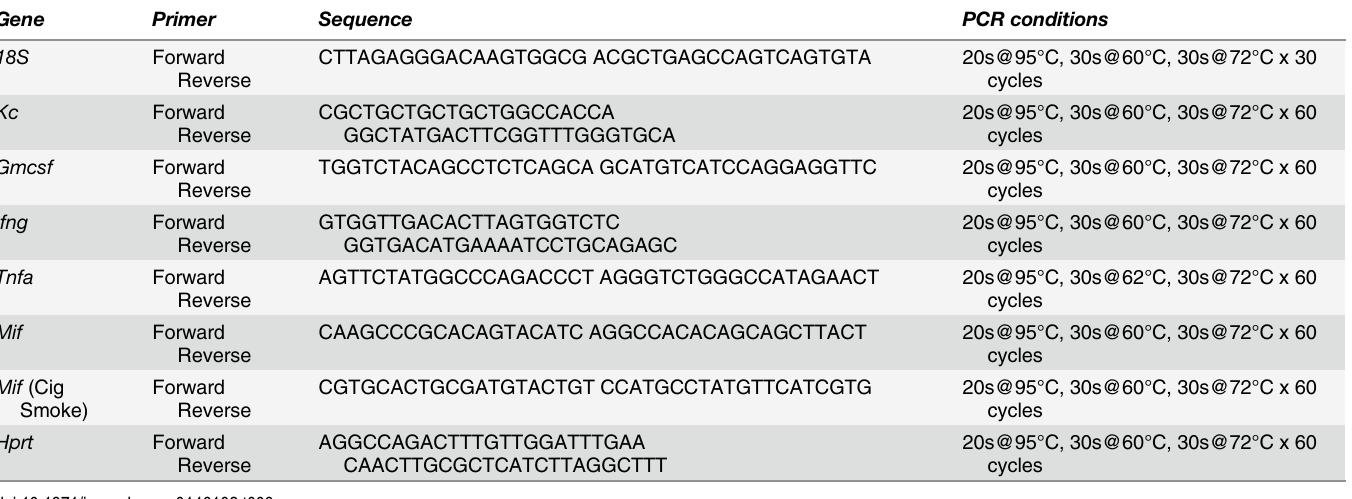
Table 3. List of forward and reverse primers and PCR